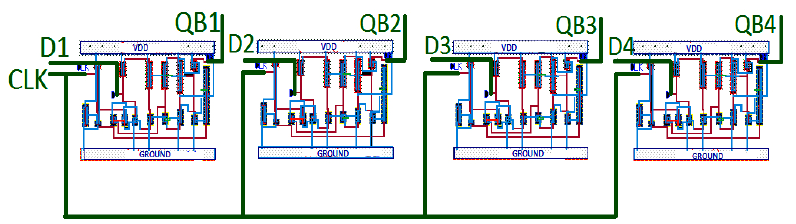
Figure 15. Layout of the PIPO shift register.